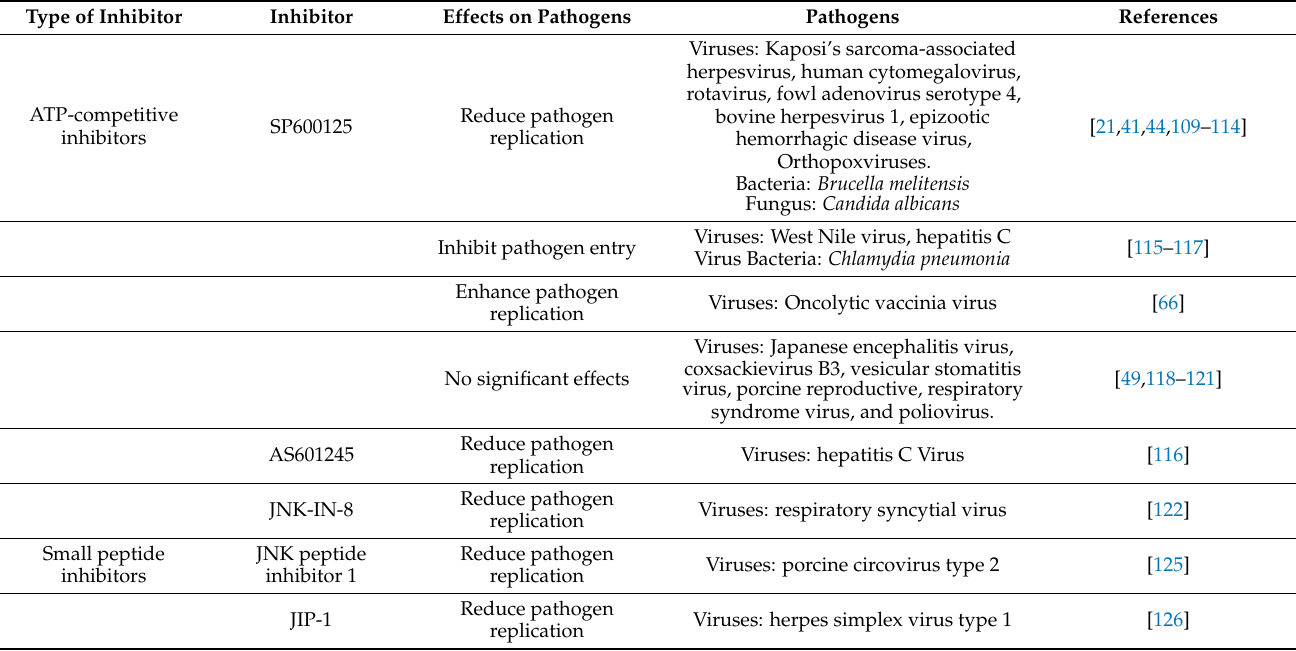
Table 1. Summary of JNK inhibitors studied in infectious